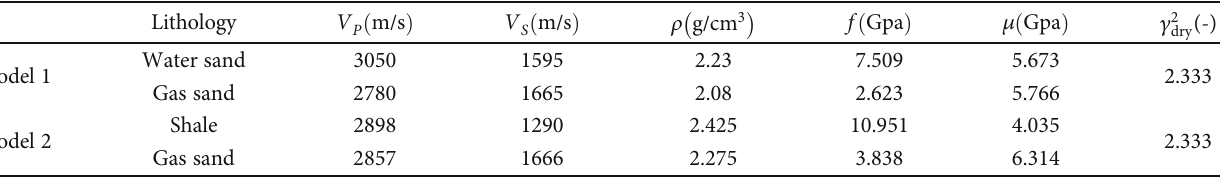
Table 1: Parameters of model 1 and model